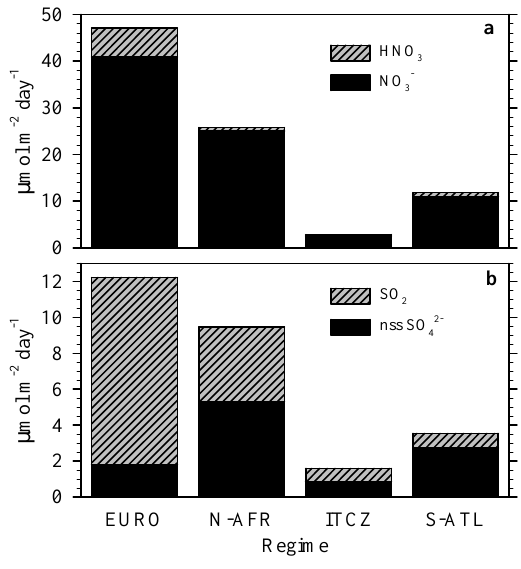
Fig. 5. Median dry-deposition fluxes of (a) HNO 3 and particulate NO − , and (b) SO 2 and particulate nss SO 2 − 3 culated from measurements as described in Sect.